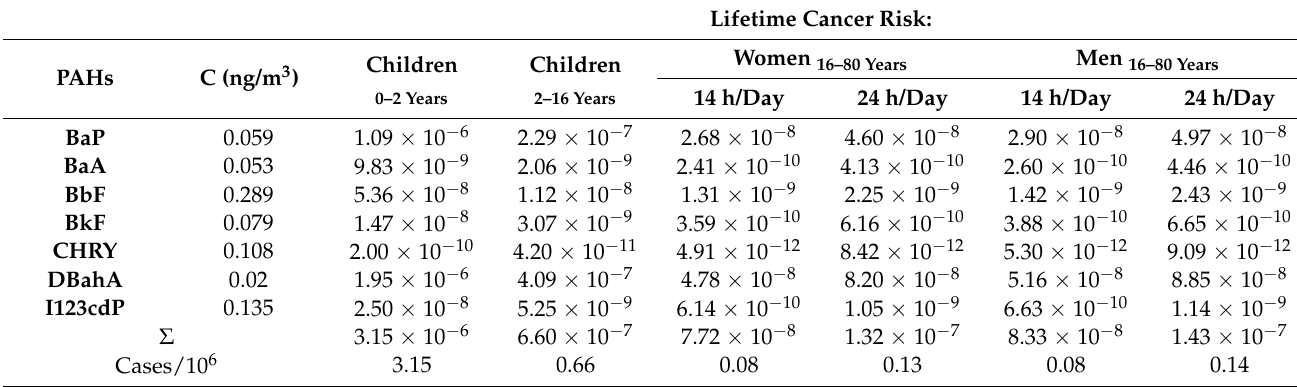
Table A1. Cancer risk assessment A.I method (Maertens, 2008).